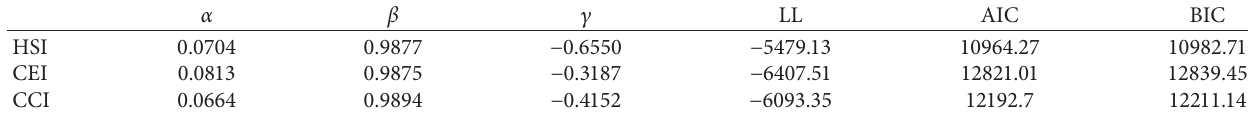
Figure 5: Moving sample standard deviation series. (a) HSI. (b) CEI. (c) CCI. Table 3: Parameter estimation of the NAGARCH